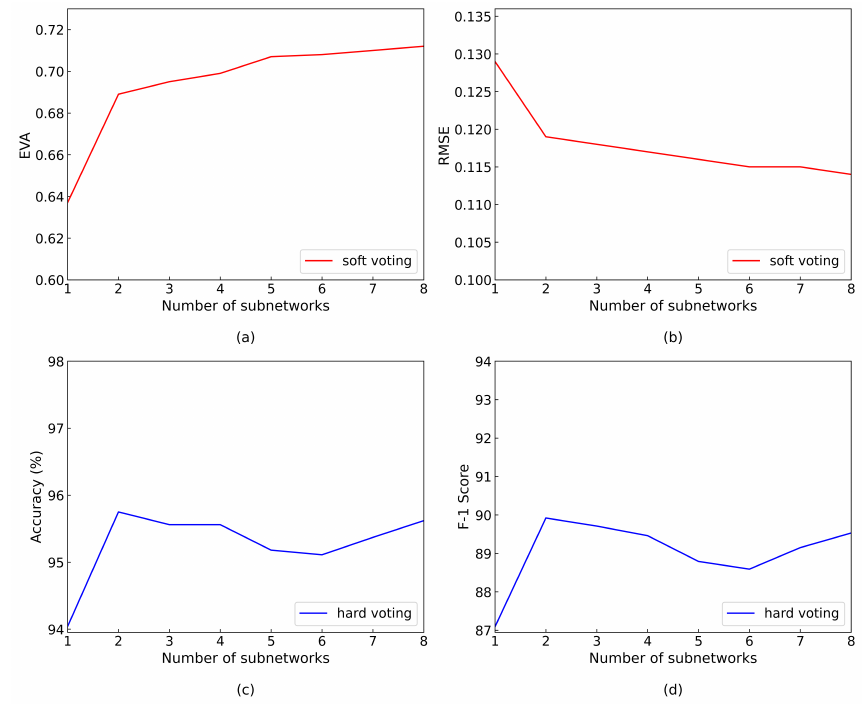
Figure 10. The performance of EBDN model variation as the number of aggregated subnetworks from 1 to 8. ( a ) EVA metric; ( b ) RMSE metric; ( c ) classification accuracy; ( d ) F-1